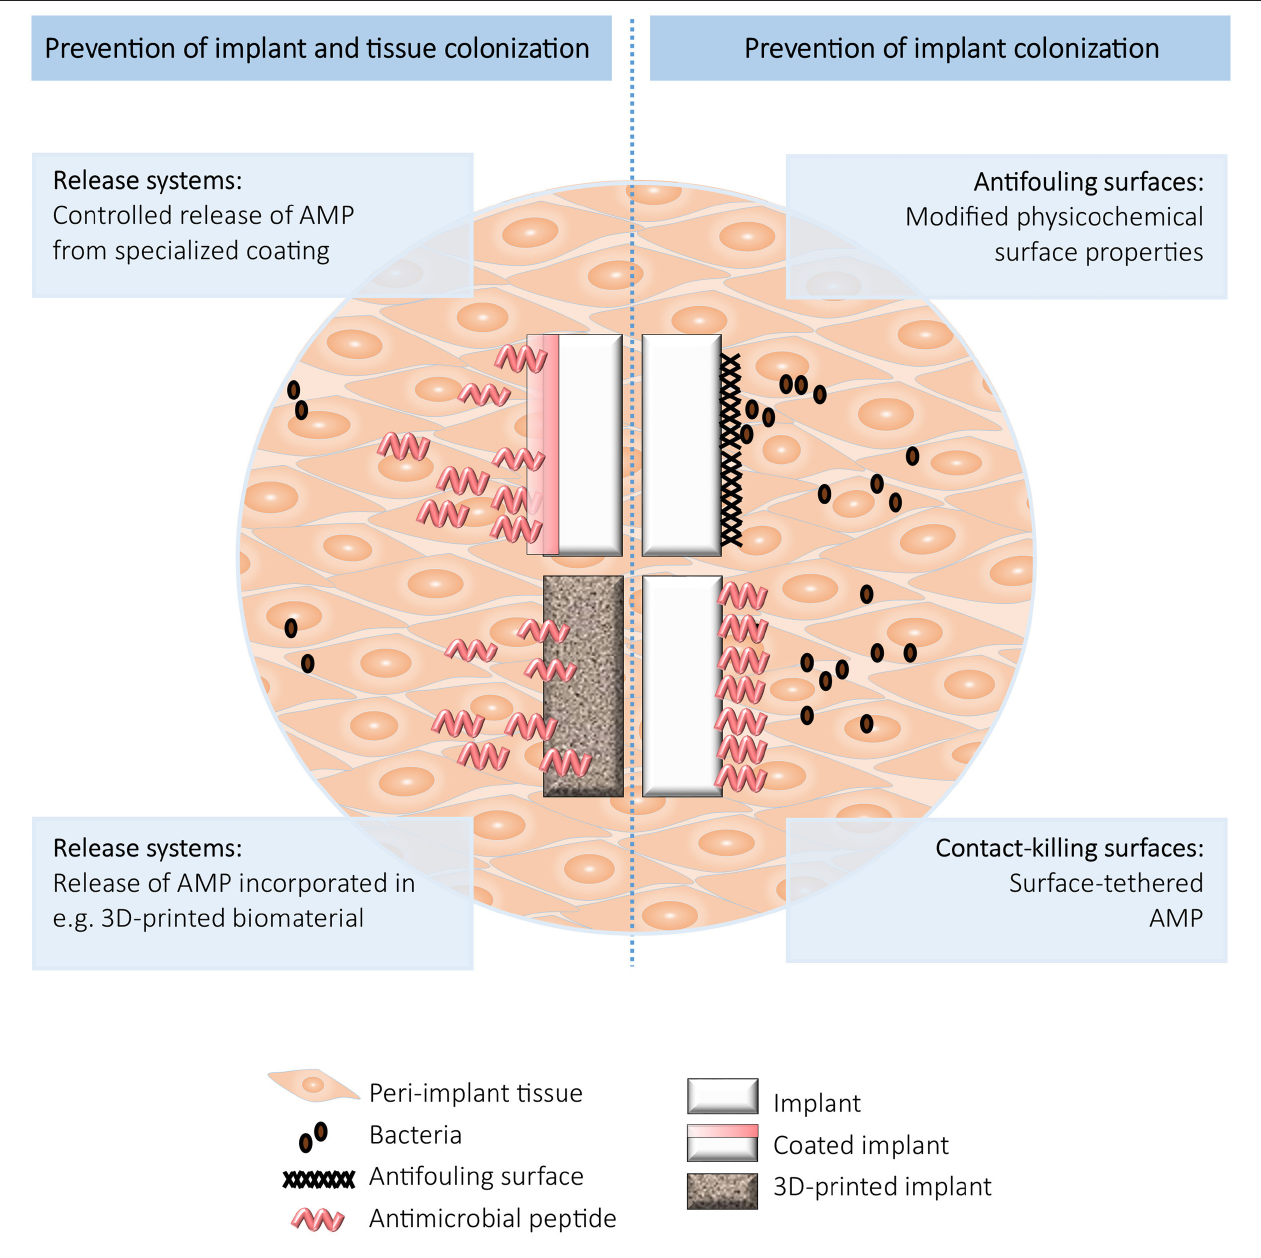
FIGURE 1 | Schematic overview of the strategies to prevent implant ( Right ) and implant and tissue ( Left ) colonization.